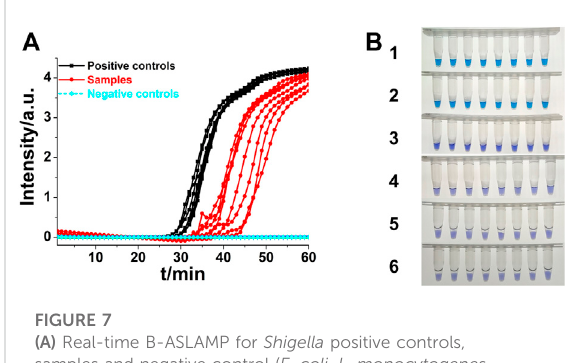
samples and negative control ( E. coli , L. monocytogenes , Salmonella , and V. parahaemolyticus ). (B) Colorimetric B-ASLAMP